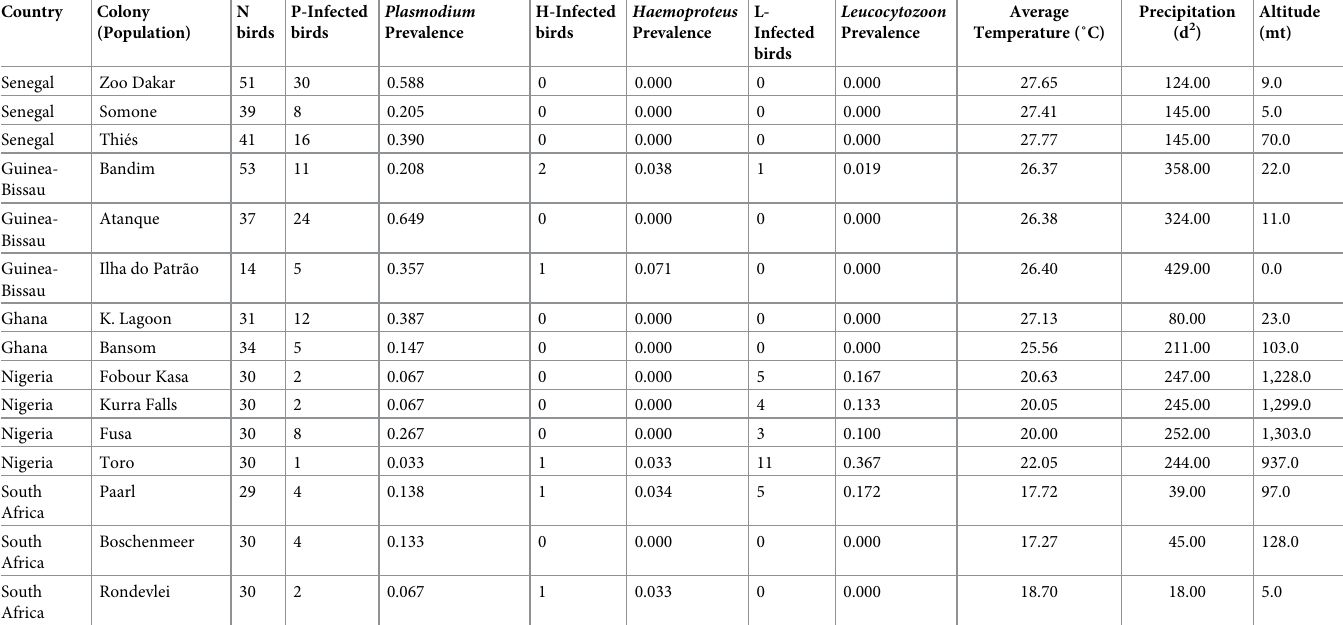
Table 2. Prevalence of three genera of haemosporidians in fifteen cattle egret colonies in central-western and southern Africa and environmental variables at these sites. Environmental variables were extracted from WorldClim 1.4 database (http://www.worldclim.org): average temperature during sampling month, precipitation dur- ing sampling month and altitude of sampling